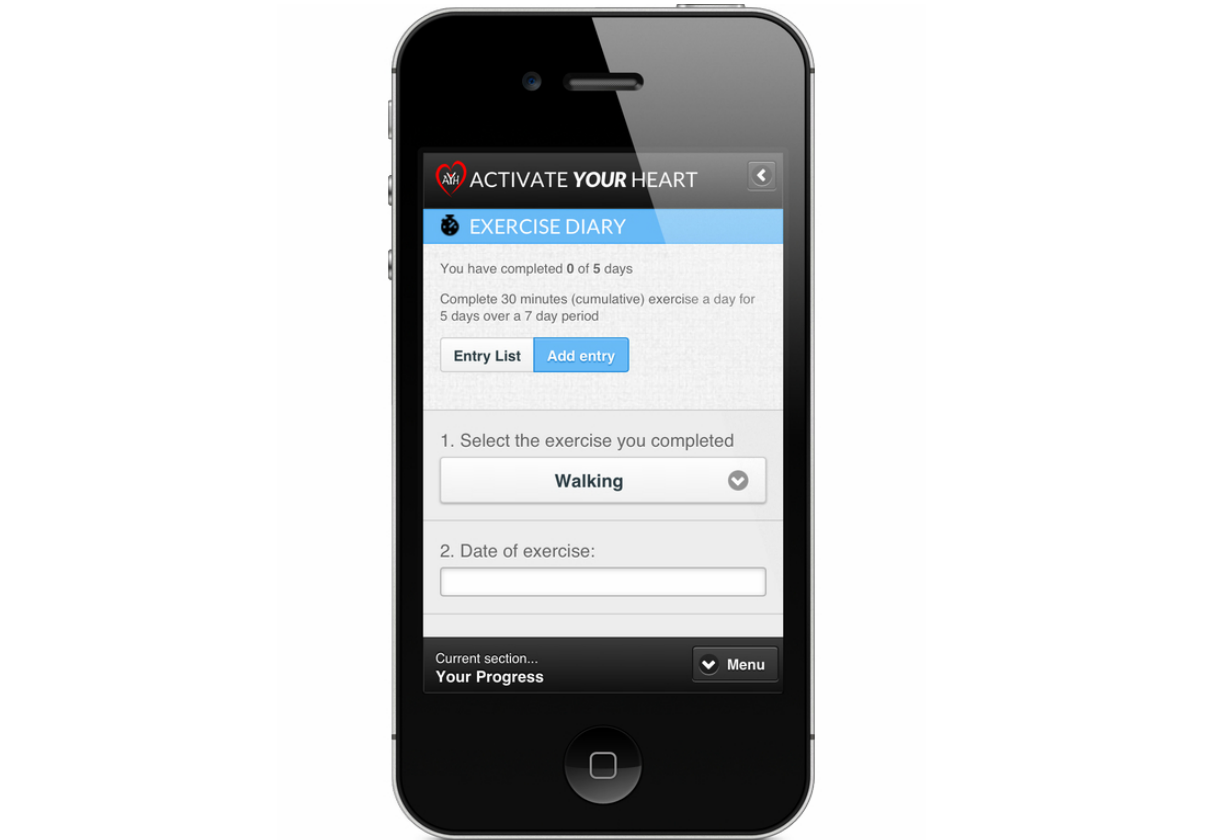
Figure 5. Adding exercise using a